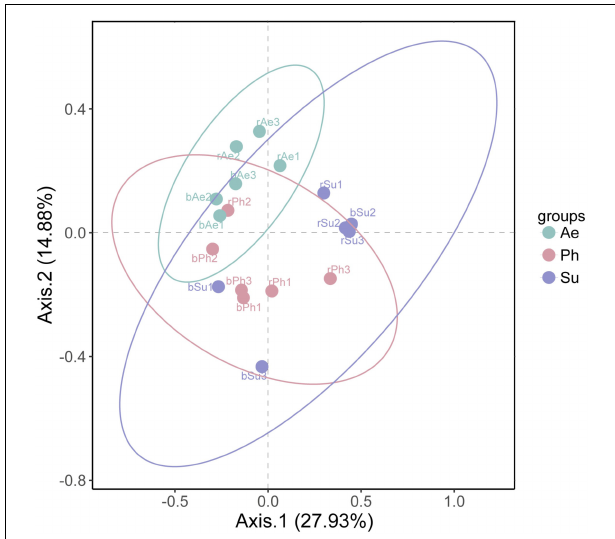
FIGURE 8 | PCoA sequence of microbial communities in rhizosphere and bulk soil of different